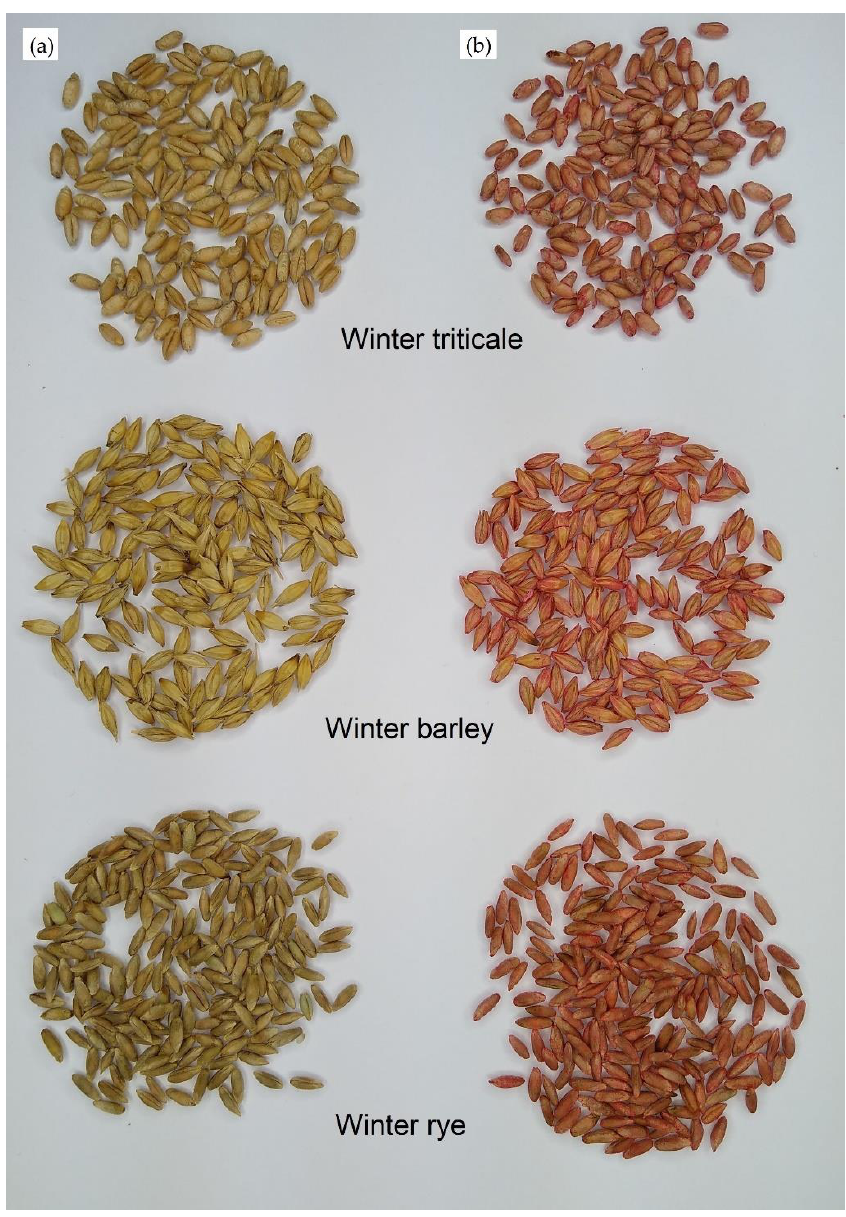
Figure 1. The seeds of three winter cereals used in the study: ( a )—untreated seeds and ( b )—dressed seeds.